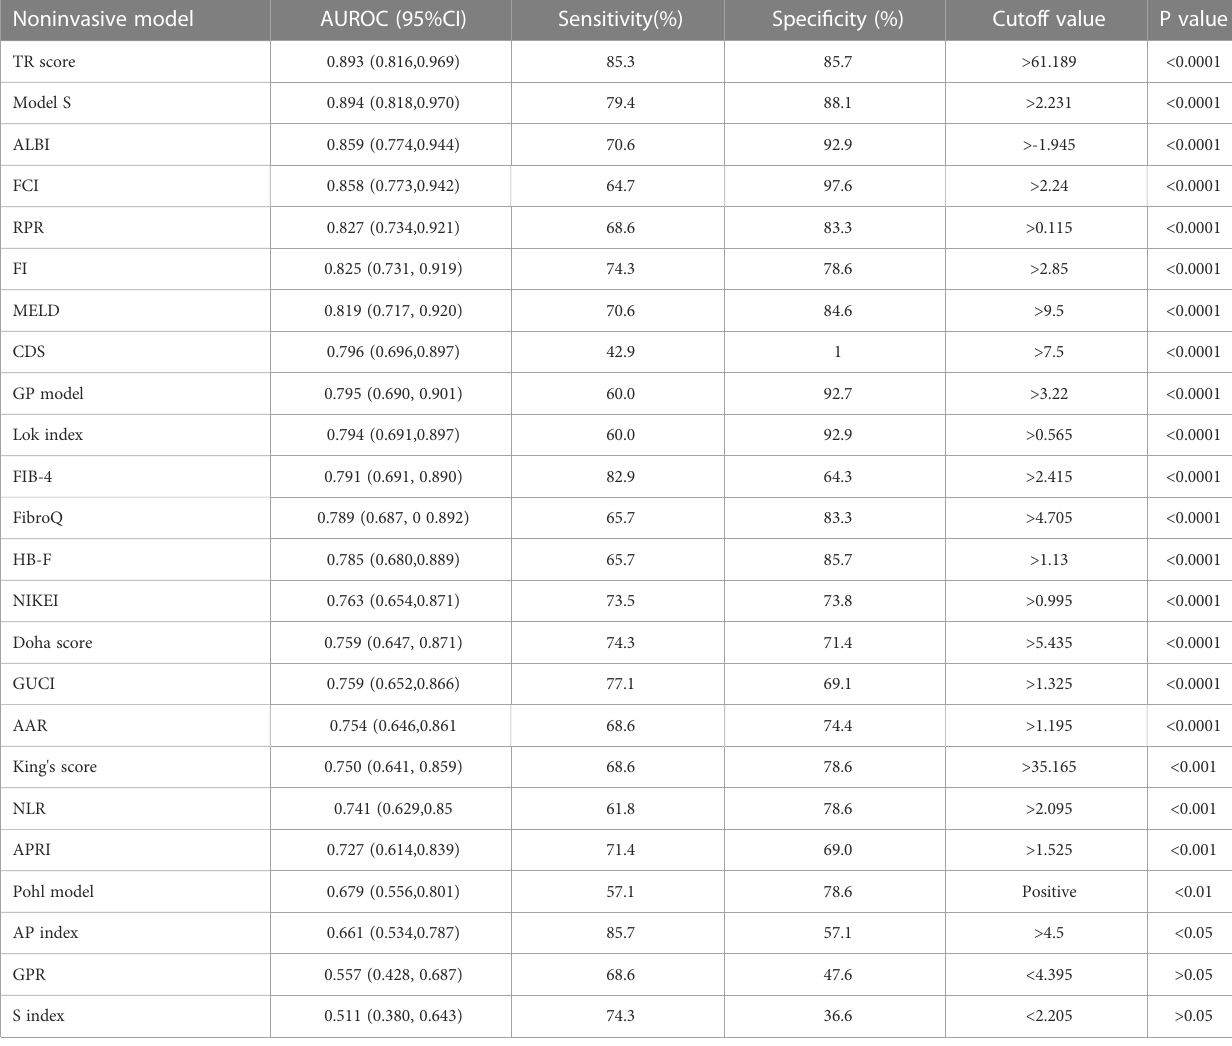
TABLE 6 Validity of each models for prediction of fi brosis and cirrhosis (S3-S4).